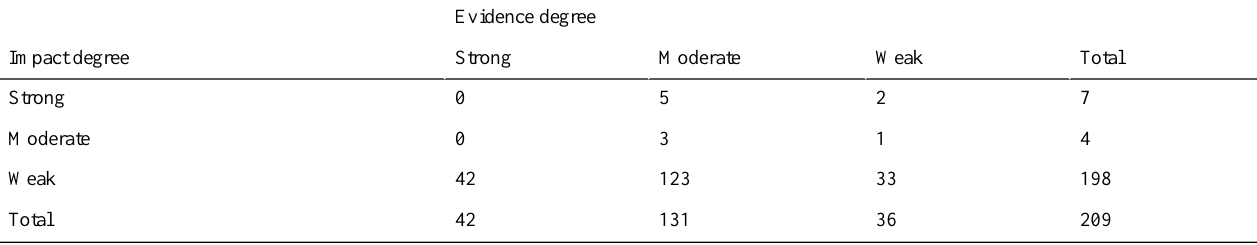
Table 5. Distribution of clinicogenomic